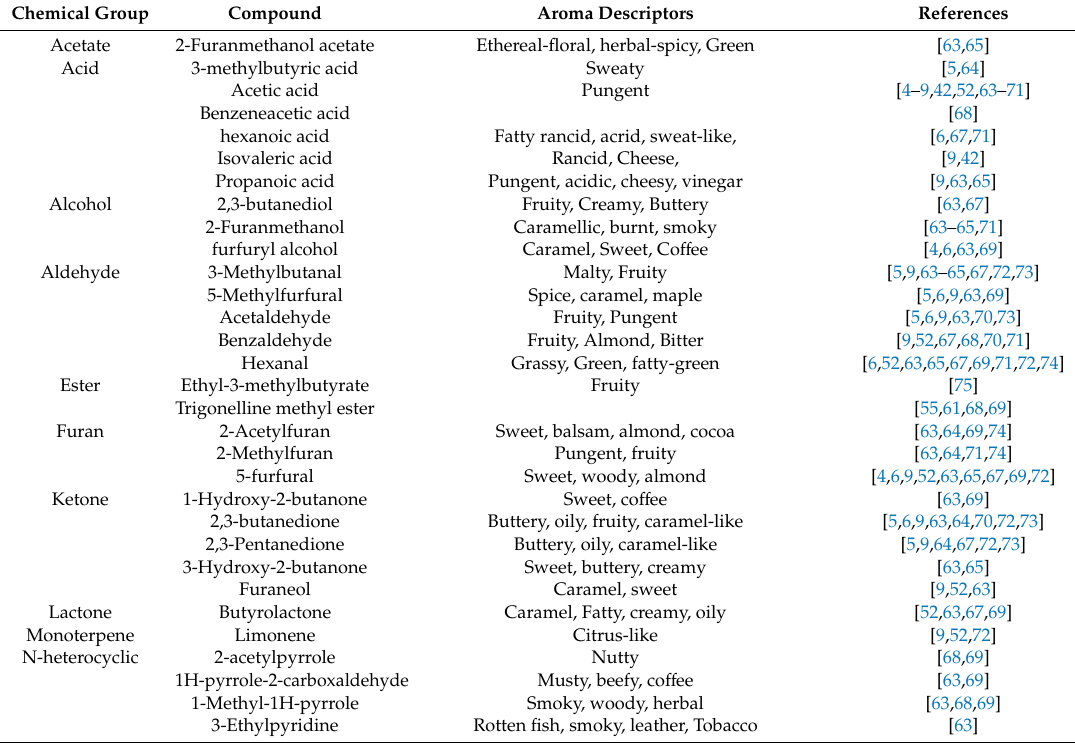
Table 2. Volatile compounds identified in roasted co ff